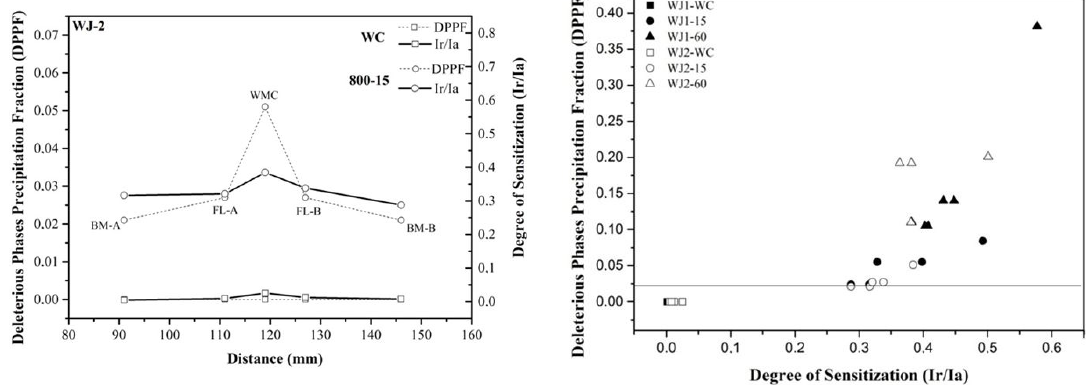
Figure 13. DOS (Ir/Ia ratio) and deleterious phases volume fraction as a function of the analyzed region for the WJ2-15 sample.